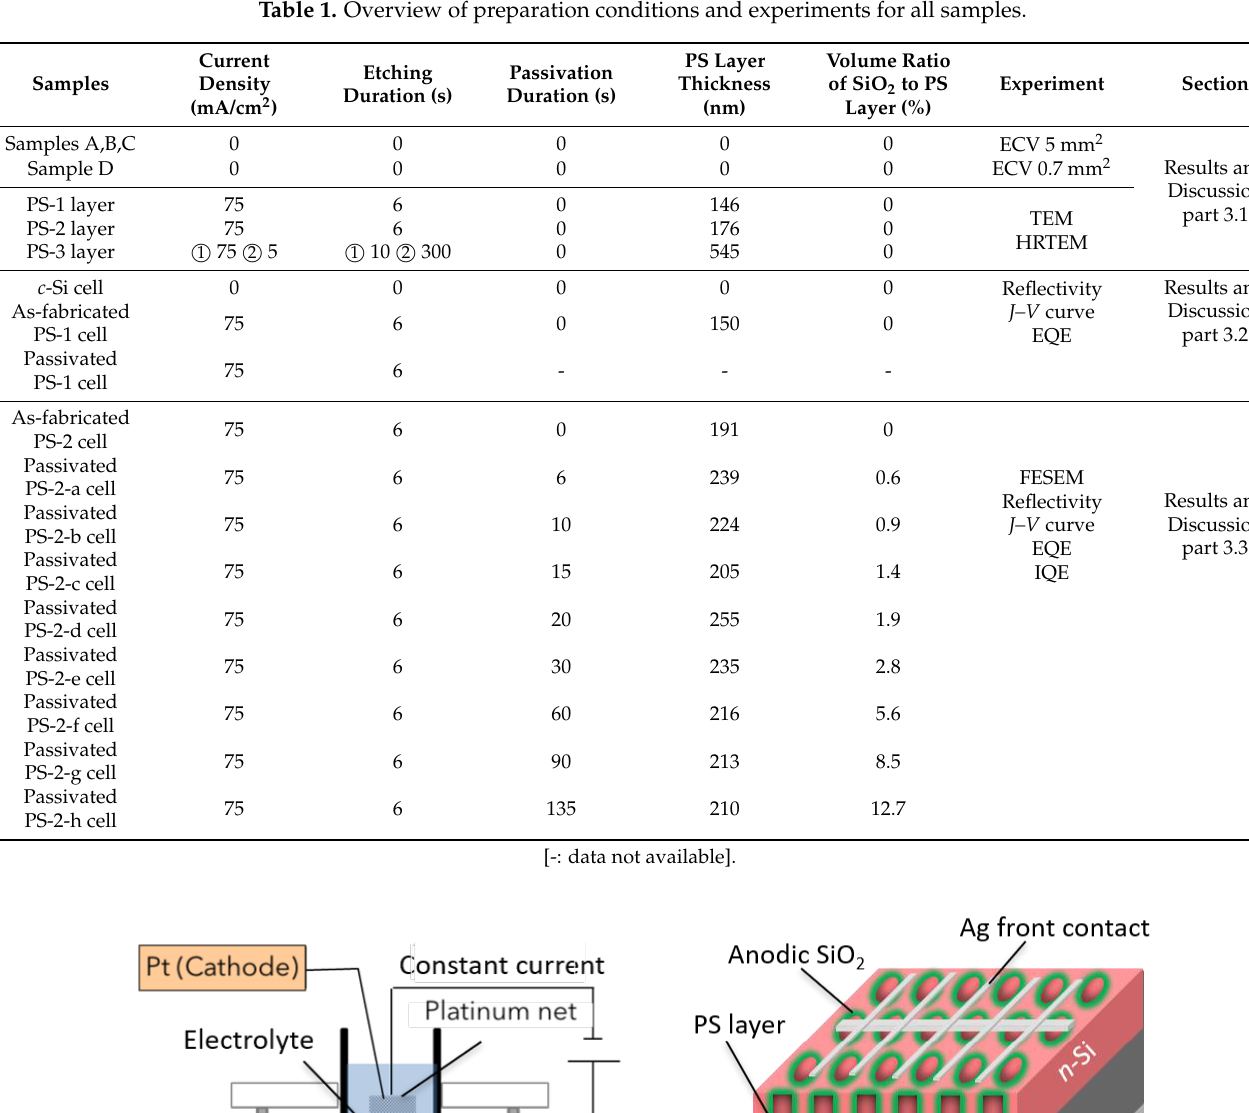
Table 1. Overview of preparation conditions and experiments for all samples.